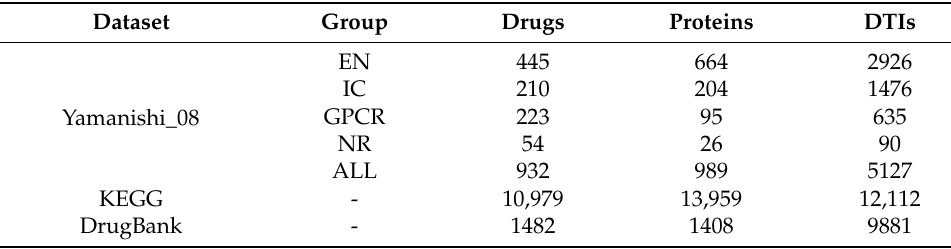
Table 1. Dataset